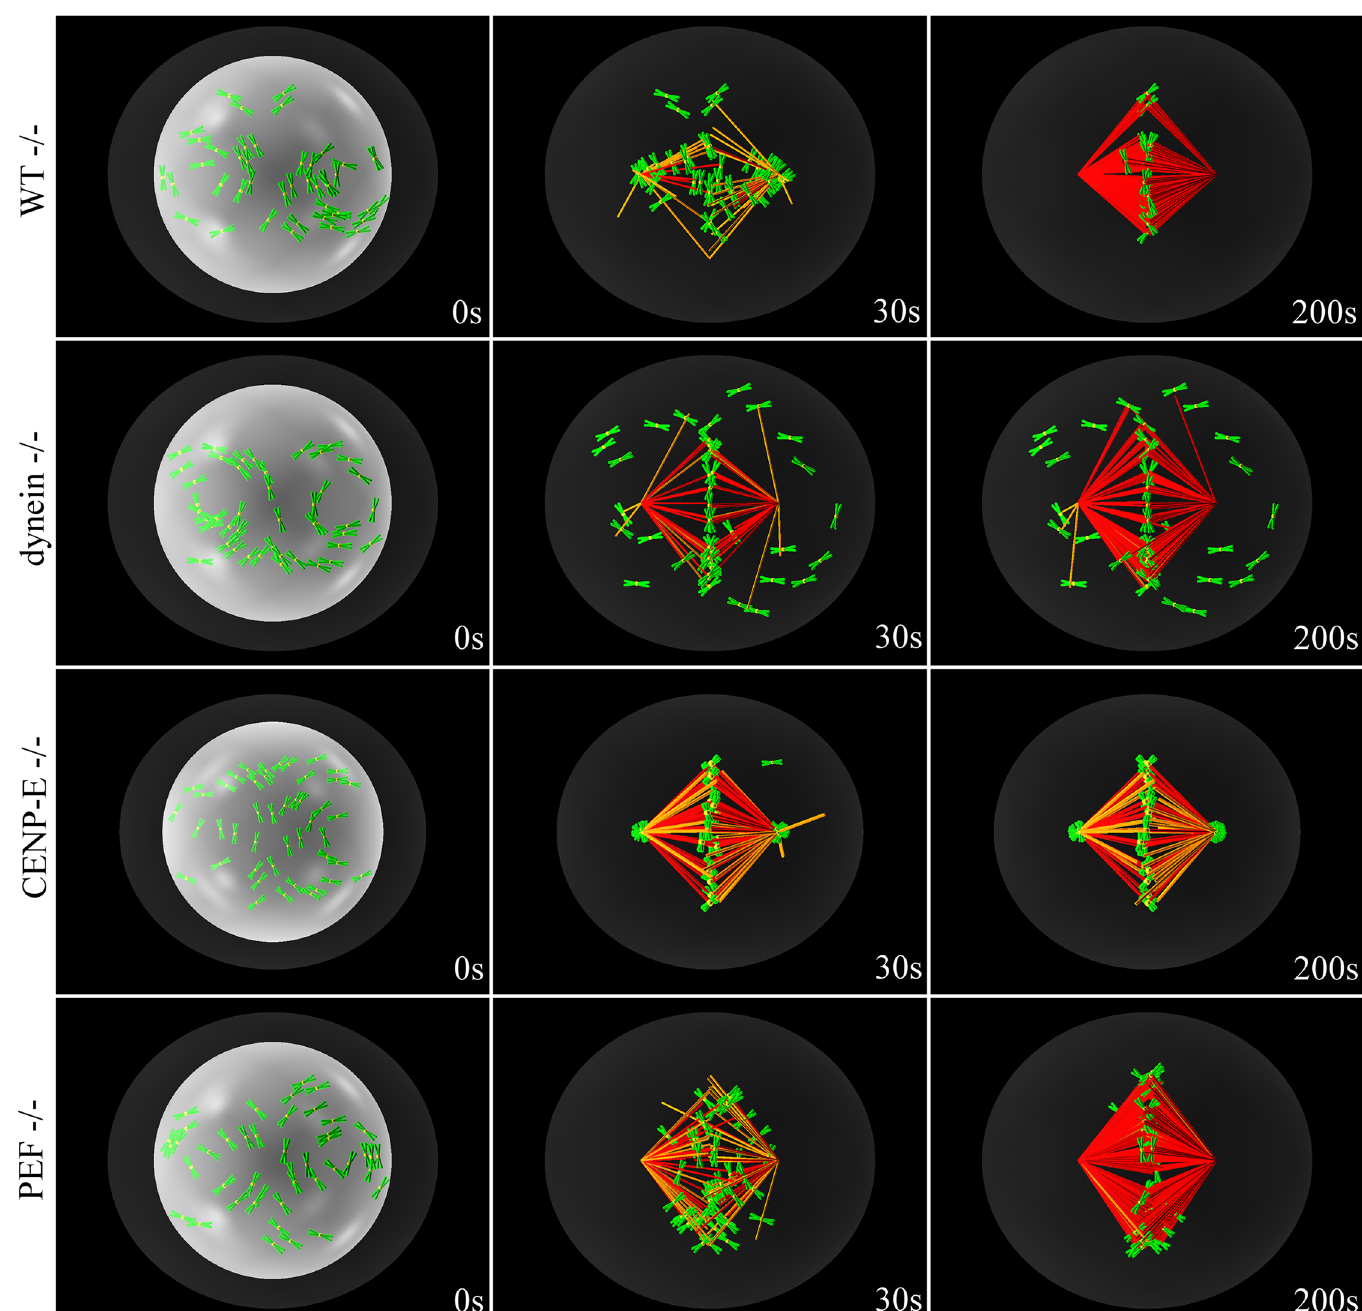
Fig 4. Time-lapse snapshots of the simulated congression process when motors are suppressed. Chromosomes are shown as having chromatid arms (green) for viewing purposes, while the kinetochores are shown as yellow spheres. Not all MTs are shown, only those that serve as rails for kinetochore motor-proteins (orange) and end-on attached MTs (red). The nuclear envelope is shown for reference in each of the first panels as a white sphere. The cortex is represented in dark grey. The wild type (WT) case, in which all motor proteins are active, is shown for comparison in row 1. When dynein is suppressed (row 2), PEFs push peripheral chromosomes to the cortex. However, when all chromosomes start between the poles, congression takes place normally. When CENP-E is depleted (row 3), peripheral chromosomes or other chromosomes that are transported to the poles get trapped there. Depleting PEFs (row 4) delays congression significantly and destabilizes the coherence of the central plate. It makes no difference whether chromosomes start all between poles or there are peripheral